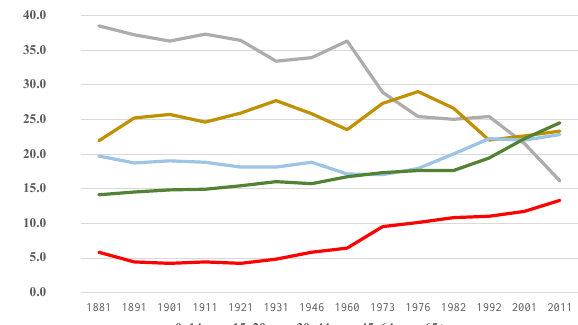
est proportion of natural change of its population ( + 4.7) and well above the EU average of − 15.9.